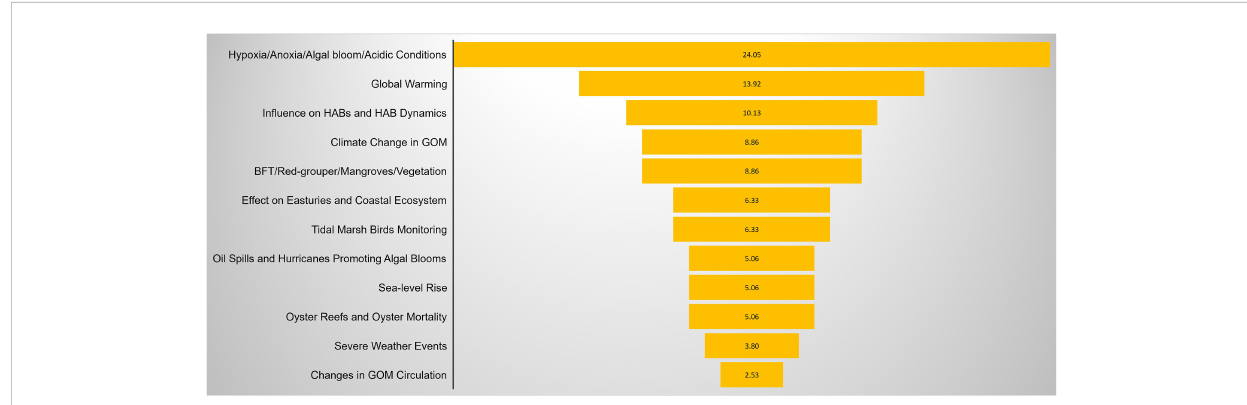
FIGURE 1 Illustration of the major categories of climate change based studies, represented per the proportion of the literature covered under each category in this